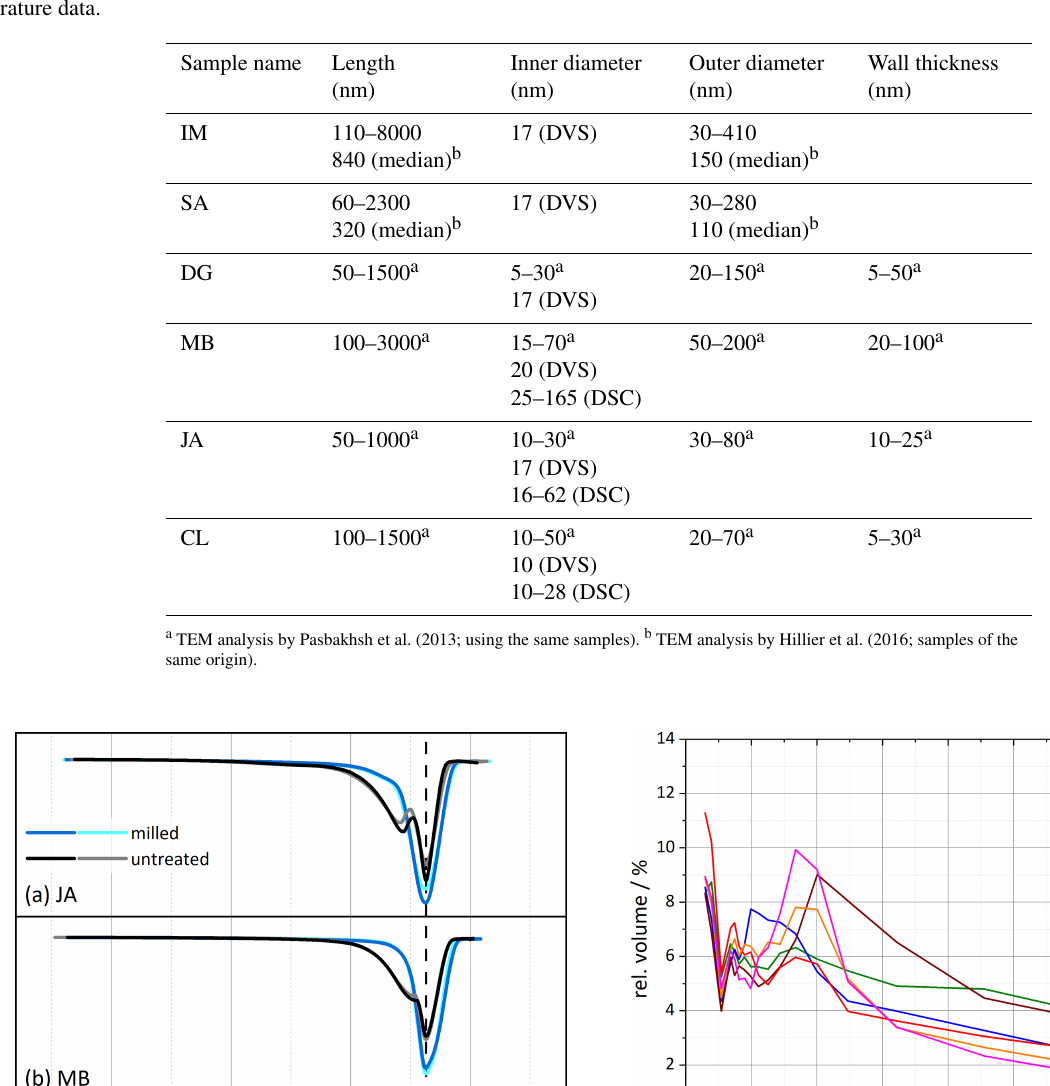
Table 2. Overview of pore parameters determined from DSC and DVS measurements in the present study in comparison with the TEM literature data.